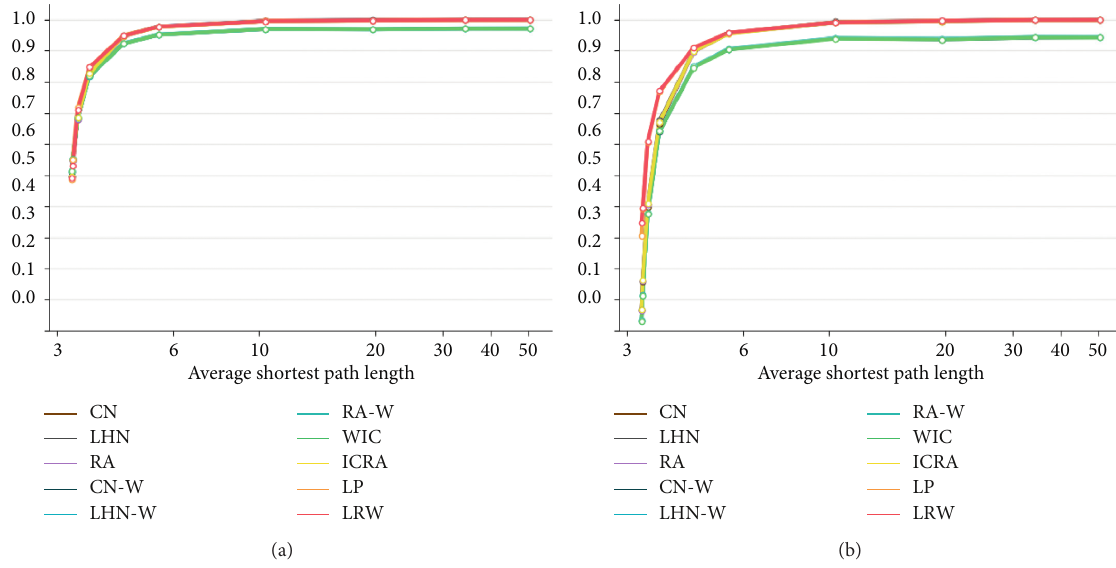
Figure 8: Performance of each predictor under AUC and W-index in WS-Group3. (a) Accuracy measured by AUC. (b) Accuracy measured by W-index.